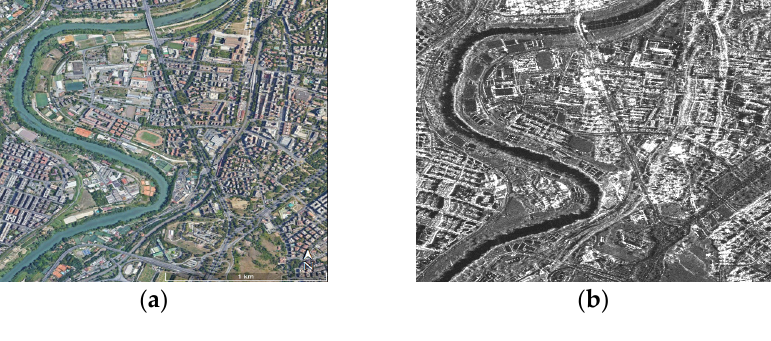
Figure 2. ( a ) Overview of the Valco San Paolo area (source: Google Earth Pro, acquired on 7 June 2020); ( b ) temporal multilook image in ascending acquisition orbit; ( c ) temporal multilook image in descending acquisition